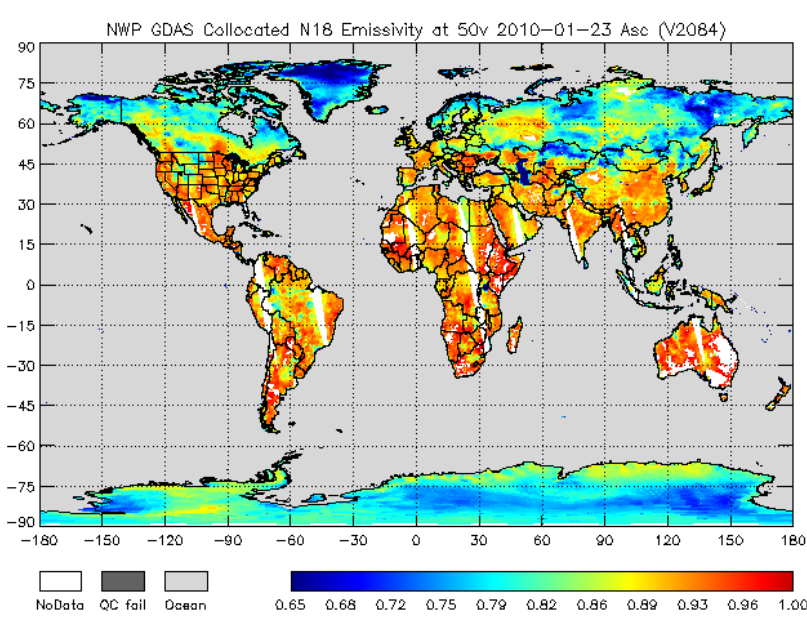
Figure 7. Global fields of non-ocean emissivity for the 50.3 GHz channel, as retrieved by the MiRS algorithm ( top ) and as provided by the analytical emissivity based on the Global Data Assimilation System (GDAS) analysis ( bottom ). The field corresponds to January 23, 2010. See text for more detail and for a discussion on the similarities and differences between the two.